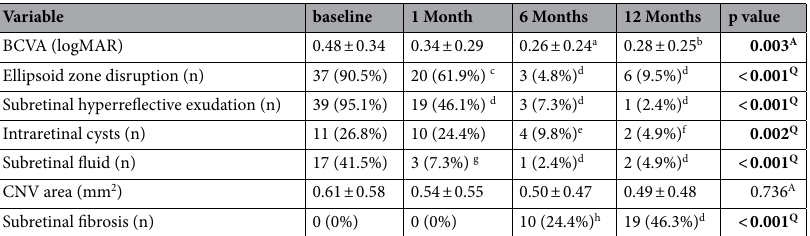
Table 2. Results of repeated variables over the follow-up study period eyes with mCNV (n = 41). Significant values are in bold. A ANOVA test; Q Cochran’s Q test; a 0.004 (Tukey HSD vs baseline); b 0.009 (Tukey HSD vs baseline); c 0.001(McNemar vs baseline); d < 0.001(McNemar vs baseline); e 0.039 (McNemar vs baseline); f 0.012 (McNemar vs baseline); g 0.001 (McNemar vs baseline); h 0.002 (McNemar vs baseline). BCVA Best-Corrected Visual Acuity, CNV Choroidal neovascularization, logMAR logarithm of the minimal angle of resolution, mm millimeter.